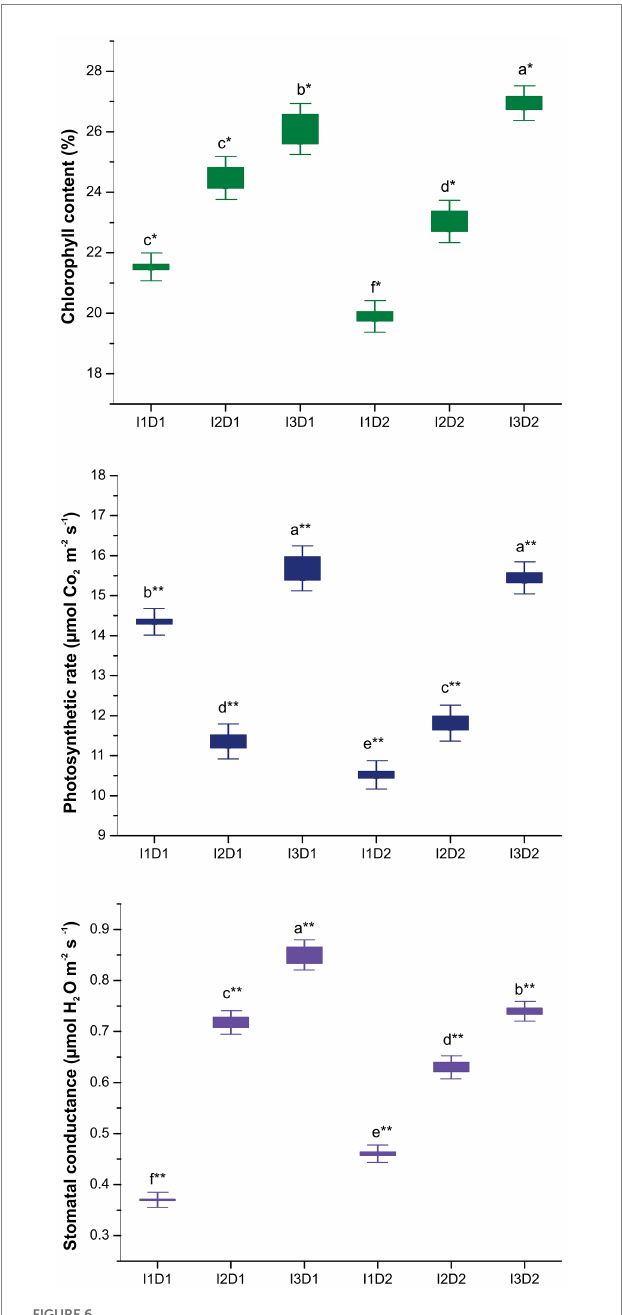
FIGURE 6 Effect of halotolerant microbial consortia dosage on physiological attributes of Vigna mungo L. under salinity. I 1 – Control; I 2 – Microbial consortium I; I 3 – Microbial consortium II and D 1 -2 kg of bioformulation per ha; D 2 -4 kg bioformulation per ha. Bars that do not share similar letters denote statistical significance. (* and ** denote significance at p < 0.05 and p < 0.01,